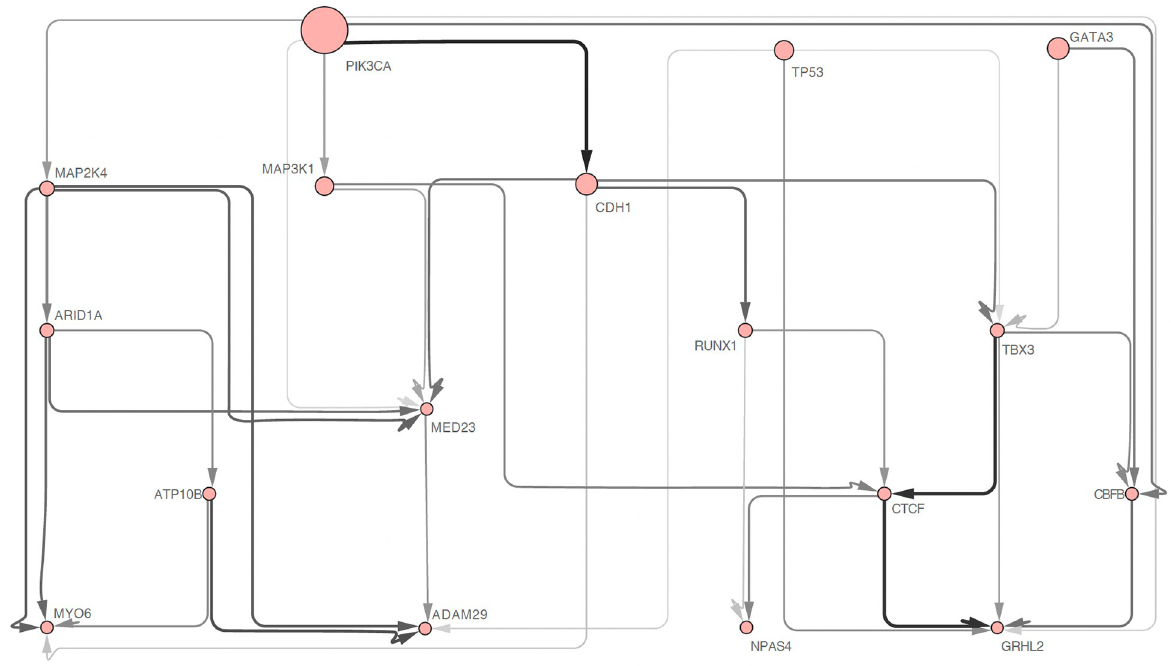
Fig 5. The oncogenetic graph inferred by TimedHN. Edge widths and shade are linear to the inter-event hazard rates. The node sizes are linear to spontaneous hazard rates.